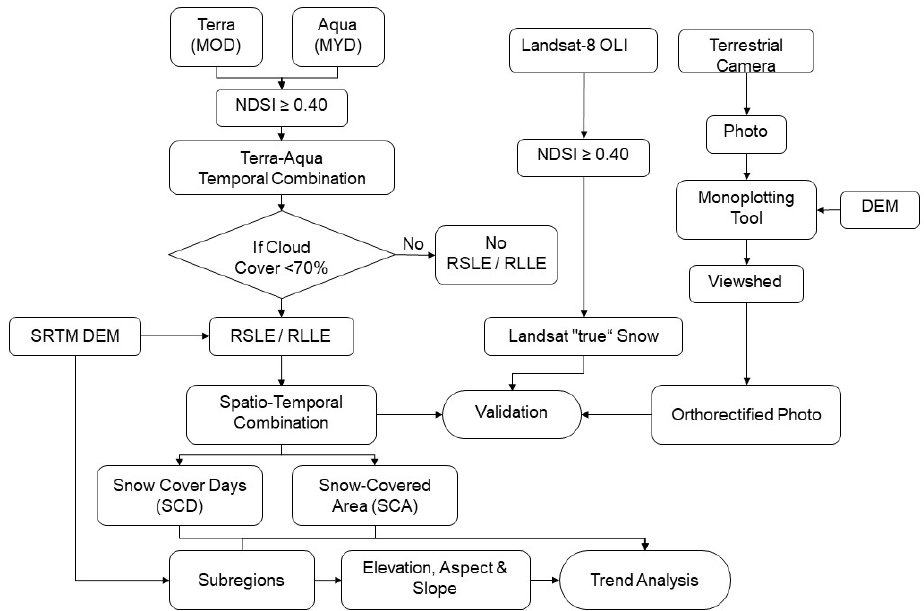
Figure 5. Flow chart of MODIS snow data processing validated with Landsat-8 imagery and orthorectified photos.